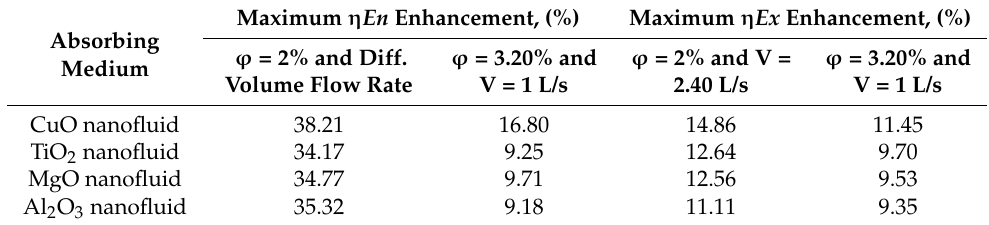
Table 5. EnE efficiency enhancement compared to the base fluid.